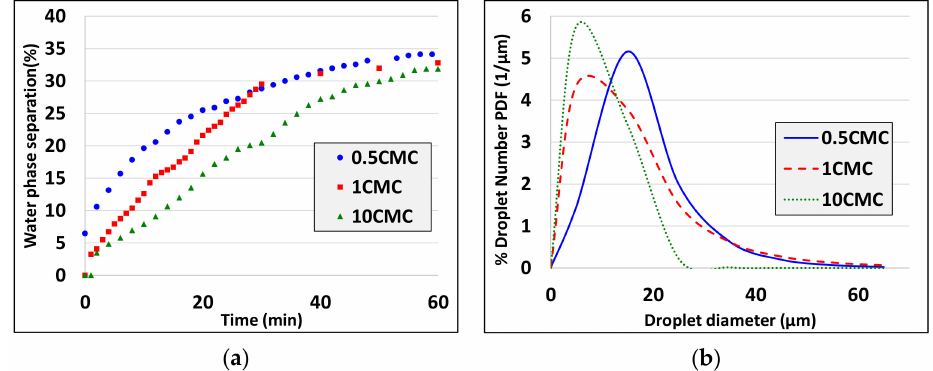
Figure 11. E ff ect of surfactant concentration C SDS on ( a ) water phase separation and ( b ) droplet size distribution of emulsions (t n = 2 min, ϕ = 0.5 and f = 10 Hz; Piston 2, 0.5 CMC: d av = 17.3 µ m, 1 CMC: